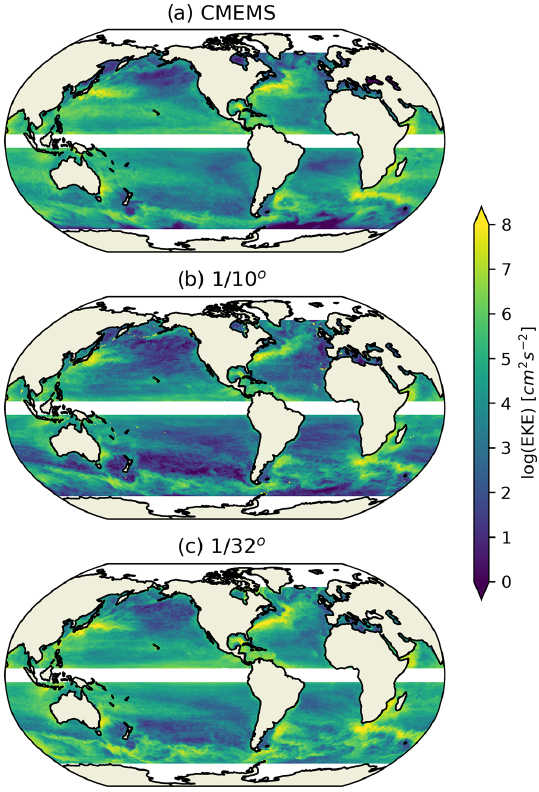
Figure 1. Eddy kinetic energy (EKE) of CMEMS from all merged and gridded satellite data (a) and the FIO-COM10 (EXP1Low) (b) and FIO-COM32 (EXP1) (c) model results.